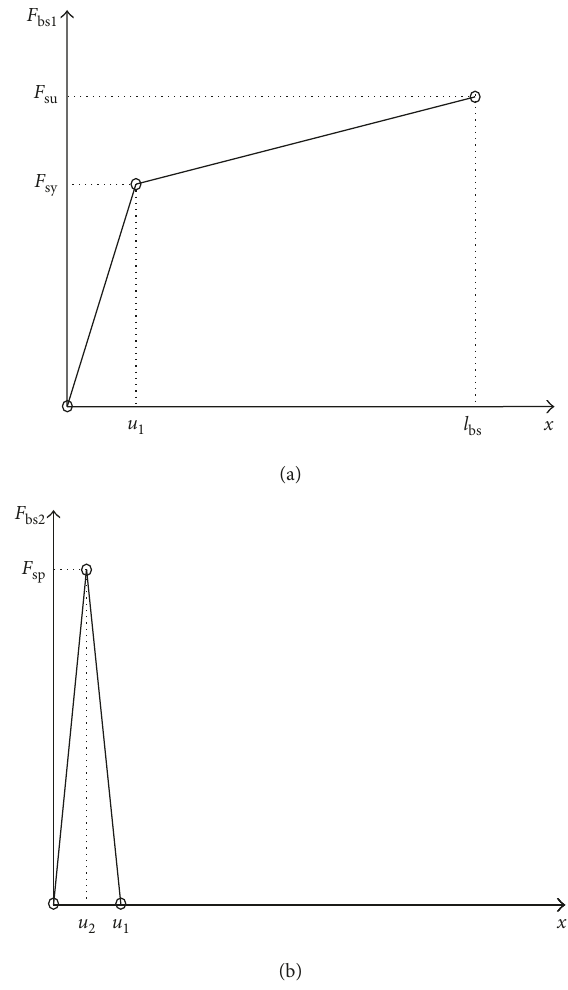
Figure 5: Bilinear spring model (a) and triangular spring model (b) used in MSM